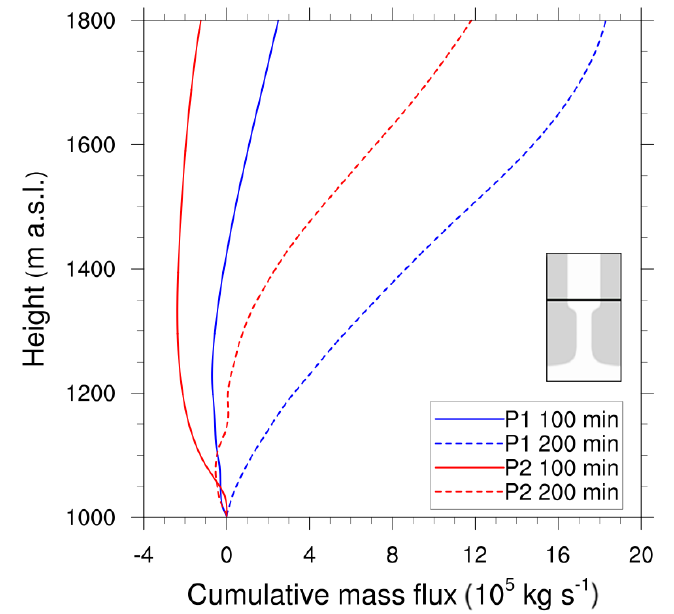
Figure 3. Cumulative mass flux across a vertical surface perpendicular to the valley axis located at 10 km from the beginning of the valley for P1 (blue lines) and P2 (red lines) at 100 (solid lines) and 200 min (dashed lines) into the simulation (with a 10 min average about these times). The calculation has been limited in the cross-valley direction to the width of the valley floor to avoid the effect of volume increase with